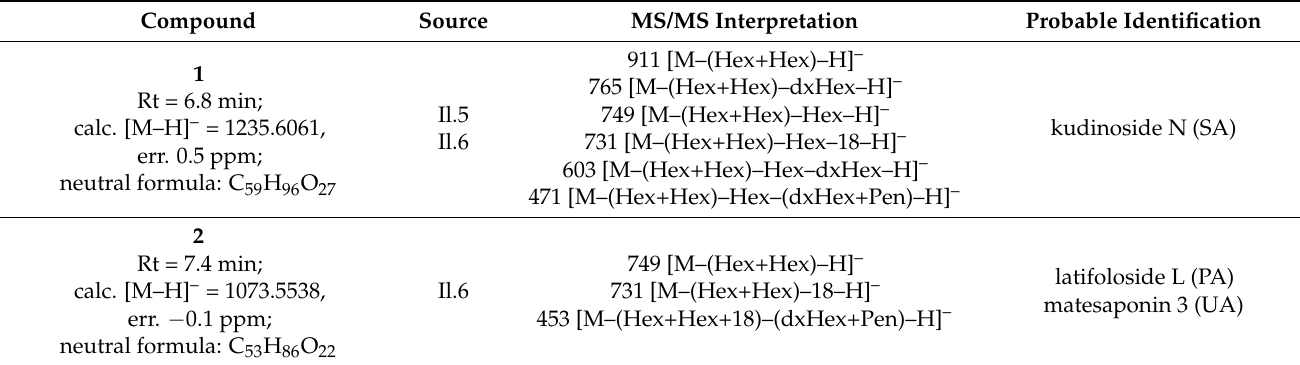
Table A3. Database- and MS/MS-based identification of main saponins present in Ilex paraguariensis (Il.1), I. aquifolium (Il.5), and I. meserveae (Il.6). Compound Source MS/MS Interpretation Probable Identification